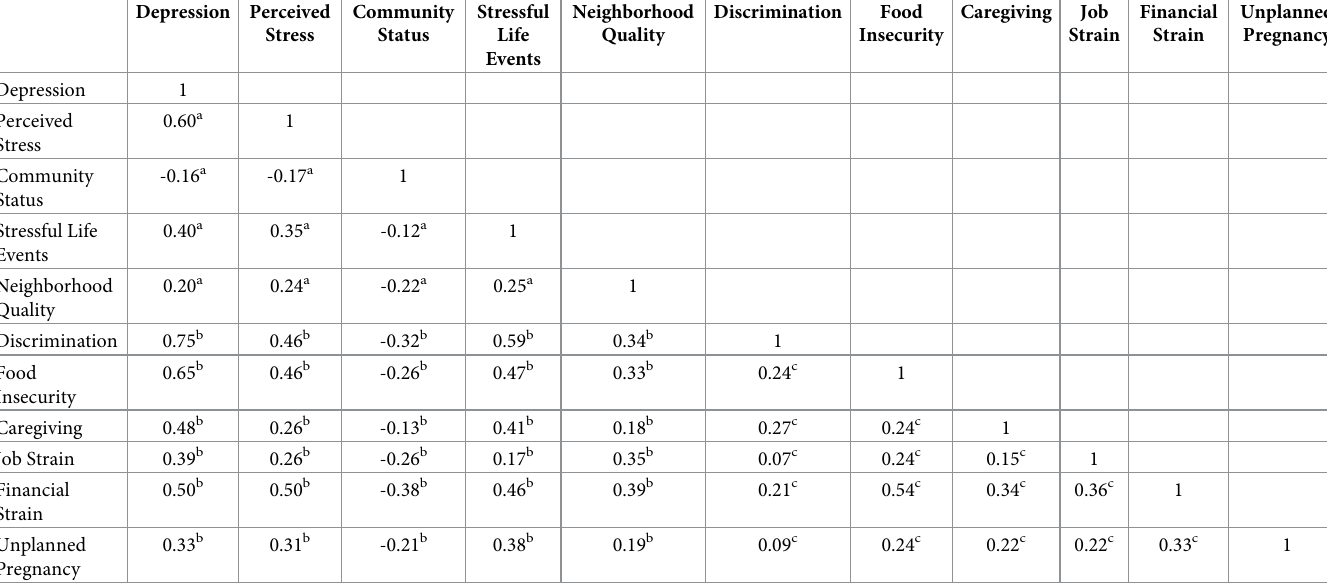
Table 2. Correlation coefficients between continuous psychosocial stress measures (stressful life events, neighborhood quality, discrimination, food insecurity, care- giving, job strain, financial strain, unplanned pregnancy) and responses to stress (depression, perceived stress, community